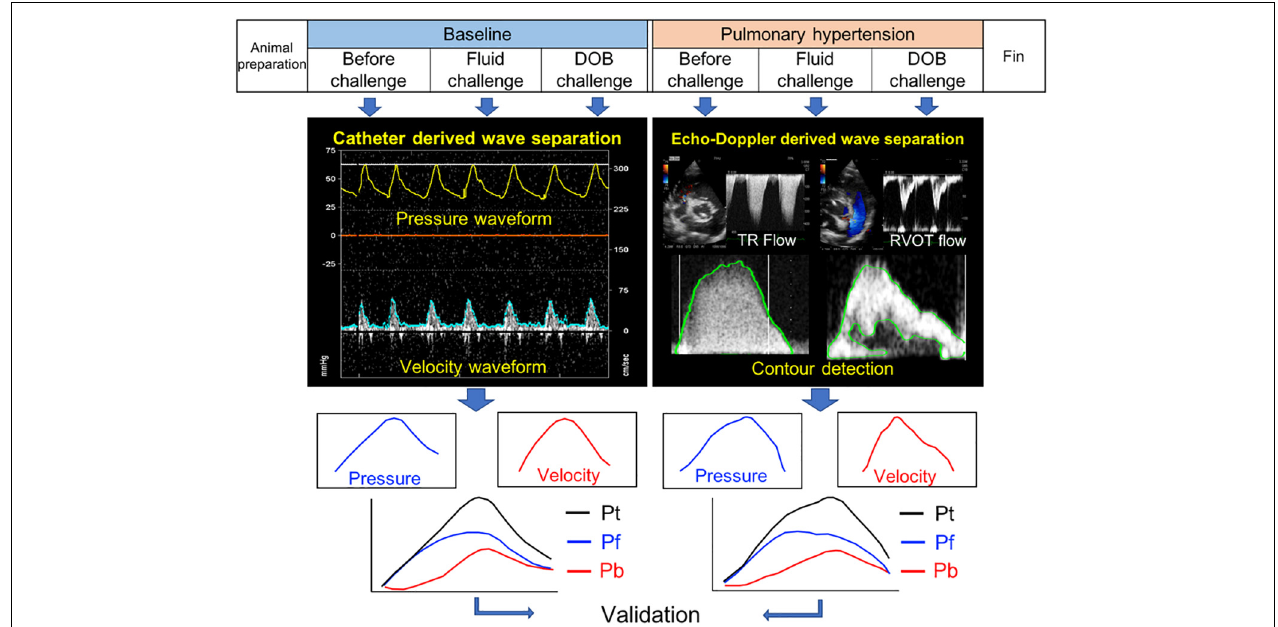
FIGURE 1 | Study design. Pt, Pf, and Pb denote pulse pressure, forward pressure and backward pressure, respectively.